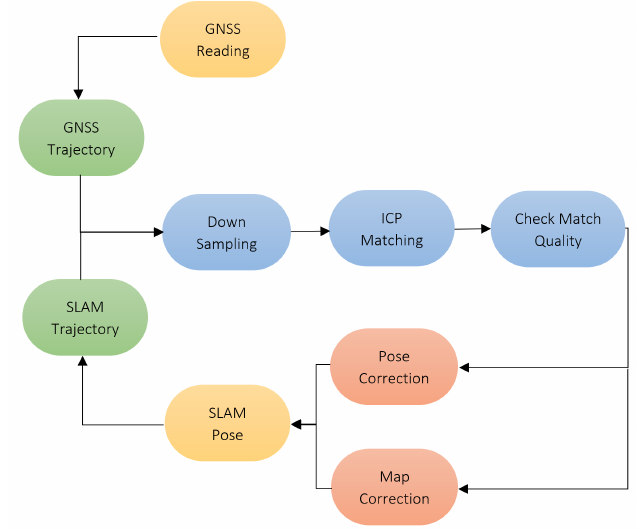
Figure 1. Explanation of the Proposed ITM